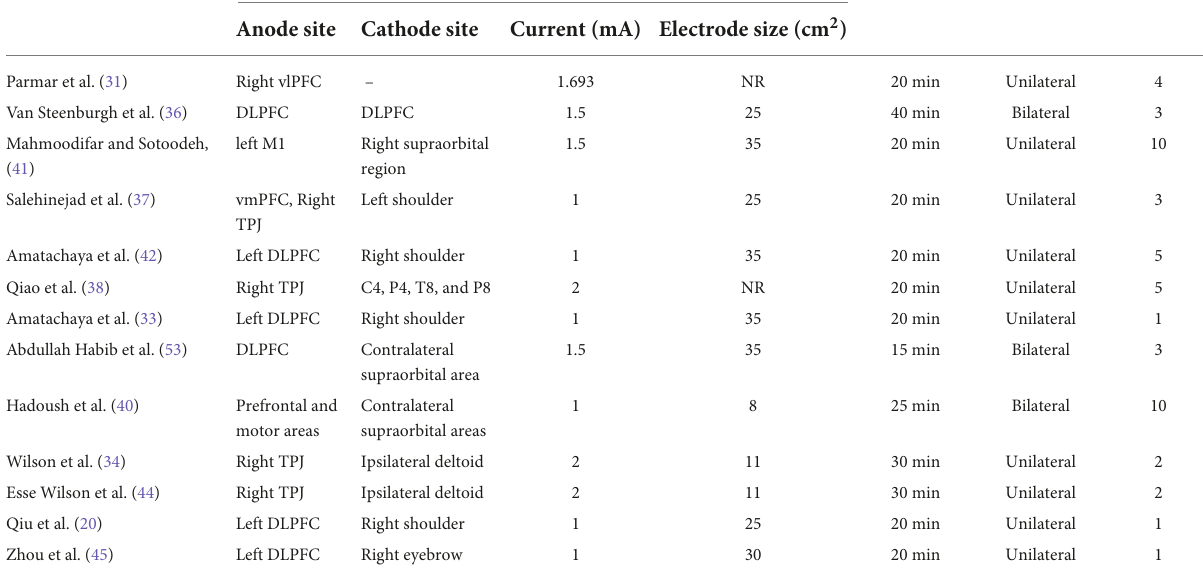
TABLE 2 Stimulation parameters for transcranial direct current stimulation.